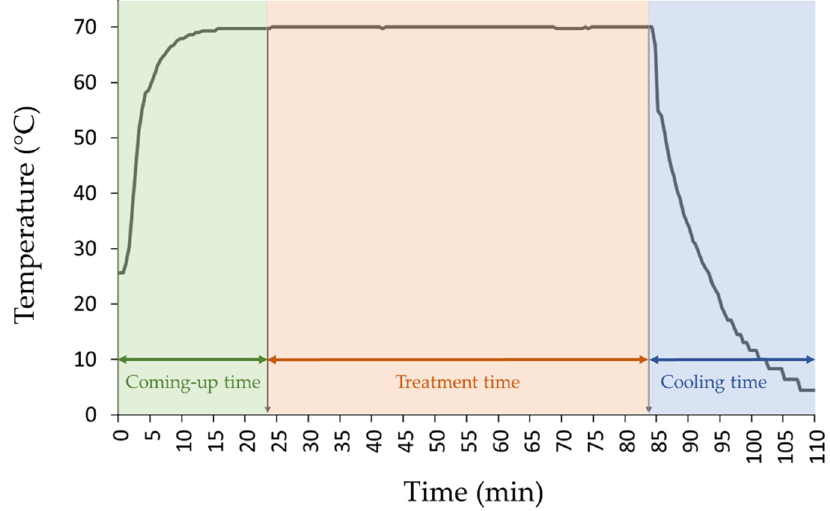
Figure A2. Temperature profile (coming-up phase, treatment phase and cooling phase) of the heat treatment (70 °C for 60 min) applied on the BSFL frass samples.